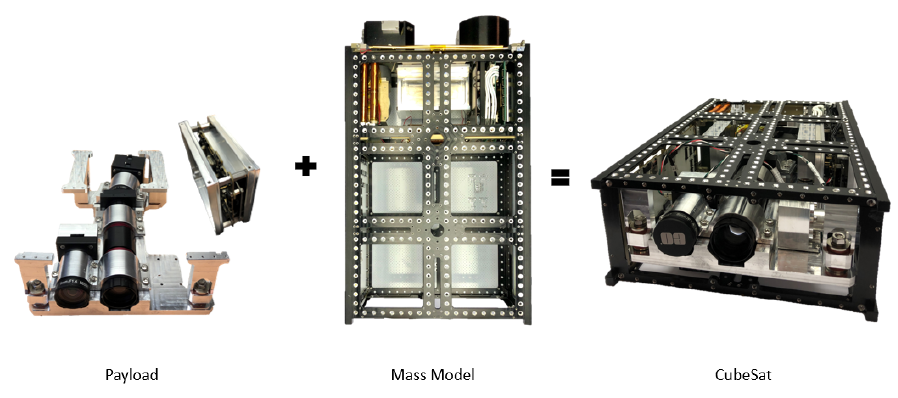
Figure 11. Integrating the payload (NTNU) with the 6U bus (NanoAvionics); cabling not shown.